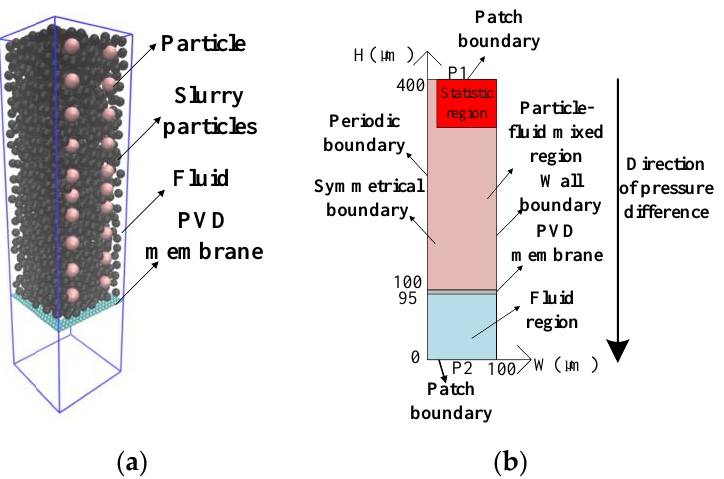
Figure 6. Diagram of the numerical model: ( a ) three-dimensional model, ( b ) model structure. In order to save computational cost as well as to simplify the calculation of particle interaction forces, the slurry particles were idealized into spheres, which were randomly scattered in the mixed region and not allowed to overlap with each other, as shown in Figure 6a. The number of the spheres was determined according to the initial void ratio of the slurry. The tracers were also modeled as spheres. However, they were evenly scattered only to the right boundary region of the model, as shown in Figure 6a, which was different from the slurry particles that were randomly distributed within the entire computational domain. Those tracer particles were tangential to the right boundary of the model, which mimics the situation that the tracer particles were scattered onto the inside surface of the observation window in the actual PIV test. As for the membrane, the constituting particles were fixed in space throughout the simulation. The pure water region merely serves to provide extra space for the continuous movement of particles that have passed through the membrane. The particle size distribution of the actual slurry that was sampled from Wenzhou of eastern China is shown in Figure 7. It was observed that the particle size generally confines to the range of 2~50 µ m with the median size d 50 ≈ 20 µ m. To make a reasonable representation of the actual slurry and also to reasonably simplify the modeling work, uniformly-sized spherical particles of diameter d = 10 µ m were adopted here to model the slurry. It was noted that d = 10 µ m was less than D = 20 µ m, which means the slurry particles were able to pass the membrane. Two concentrations of slurry particles that can be equivalently expressed as the initial void ratio e 0 = 2 and 3 were considered for the slurry.